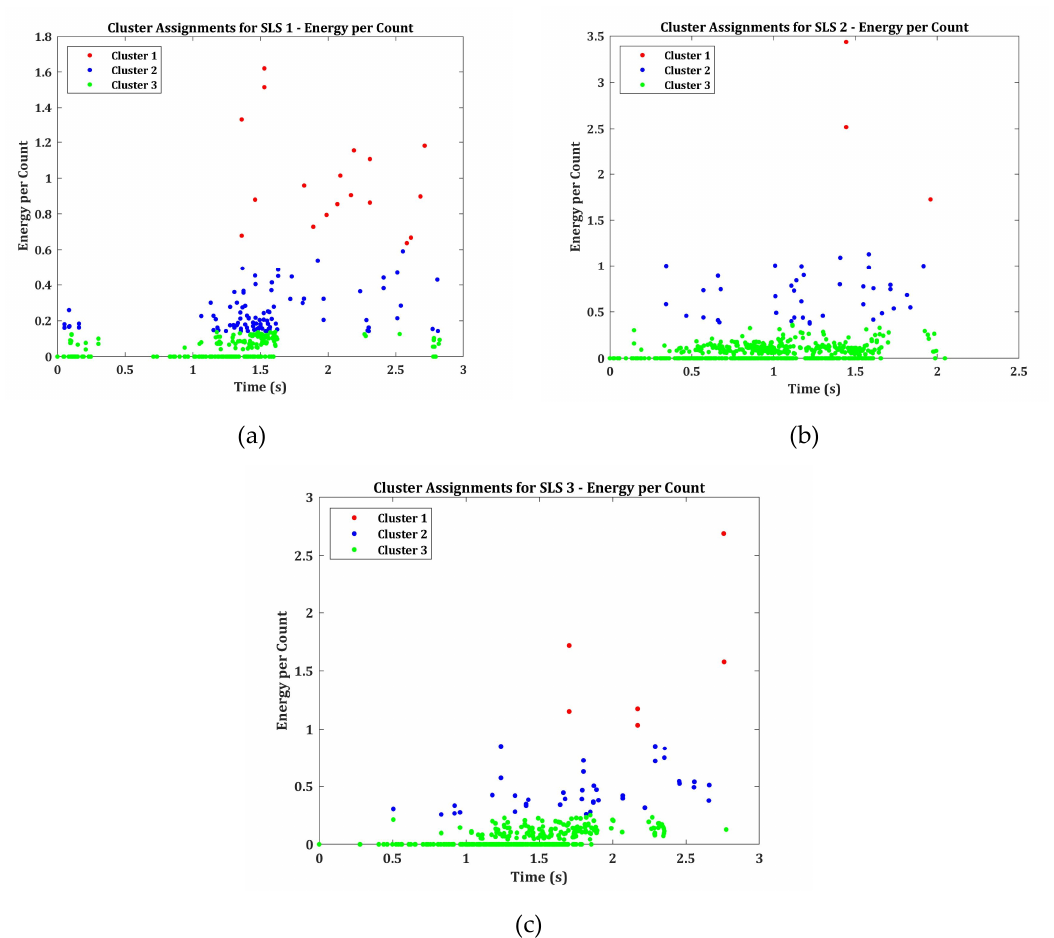
Figure 9. Clustered Energy per count for Specimens ( a ) SLS 1 ( b ) SLS 2 and ( c ) SLS 3.